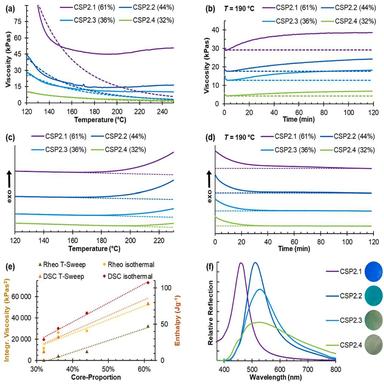
Analysis of the temperature stability of CSP with different core-to-shell proportions. The core proportion according to TEM measurements is depicted in brackets behind the respective batch. (a) Temperature-dependent rheological examinations in ambient atmosphere in terms of dynamic complex viscosities. In a temperature range from 35 ◦C to 165 ◦C measured viscosities were fitted to Arrhenius-Law and extrapolated for temperatures > 165 ◦C. (b) Isothermal rheological examinations in ambient atmosphere. The min